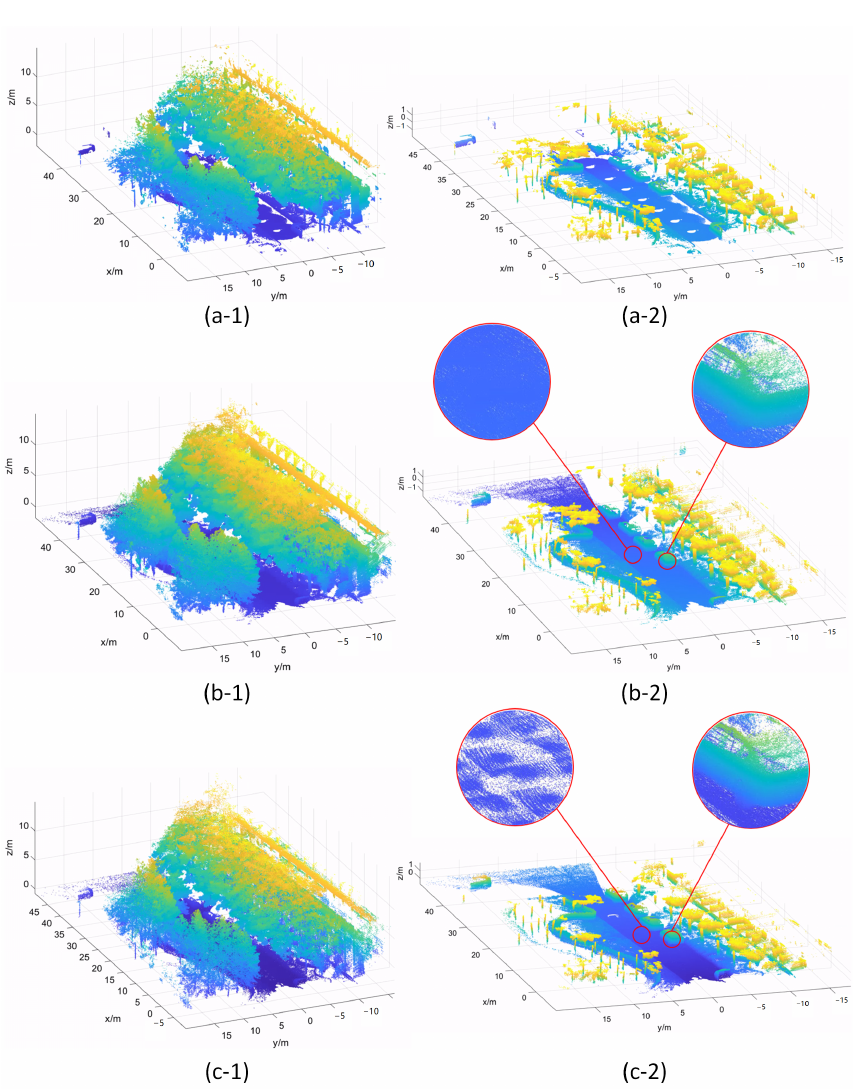
Figure 10. The result of the outdoor environment mapping experiment (colored by depth). ( a-1 , a-2 ) show the ground truth. ( b-1 , b-2 ) show the mapping result without variable resolution strategy. ( c-1 , c-2 ) show the mapping result with variable resolution strategy. The full maps are on the left, and the interior details are on the